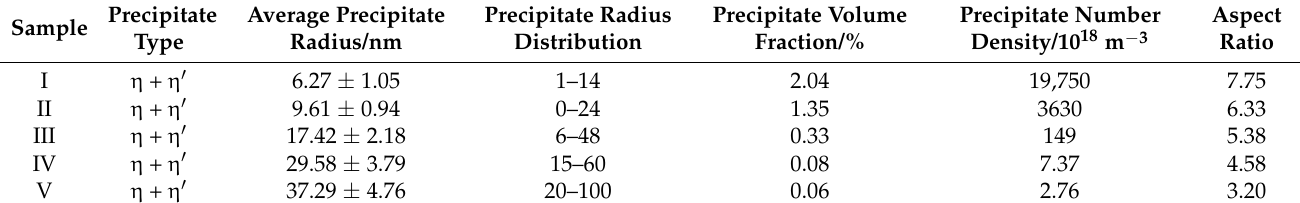
Table 3. The precipitate parameters of the samples after different heat treatment processes. Sample